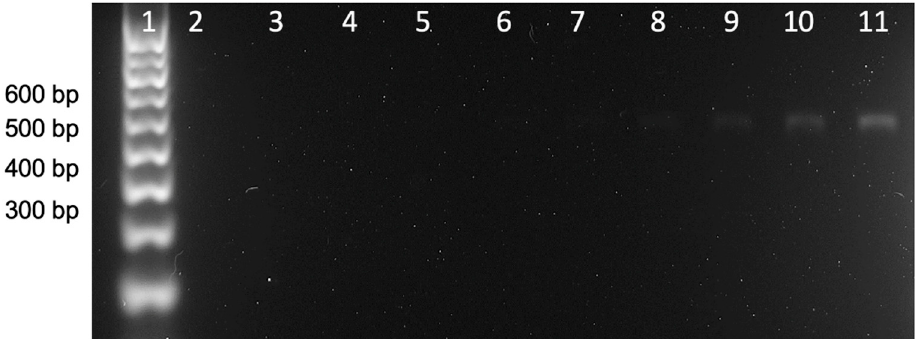
Figure 4. Gel electrophoresis of the double-tagging PCR amplification of the E. coli 16S ribosomal gene, including an initial step at 95 °C for 3 min followed by 25 cycles of 95 °C for 30 s, 58 °C for 30 s, 72 °C for 30 s, and a final step of 7 min at 72 °C. The amplification bands correspond to the E. coli 16S ribosomal gene (527 bp). Lane 1 is the molecular weight marker. Lane 2 corresponds to the negative control in which no DNA template has been added to the PCR mixture, while lanes 3–11 show the amplicon corresponding to DNA template concentrations at 0.1, 0.2, 0.4, 0.9, 1.8, 3.5, 7.1, 17.7, and 35.5 pg μ L − 1 .